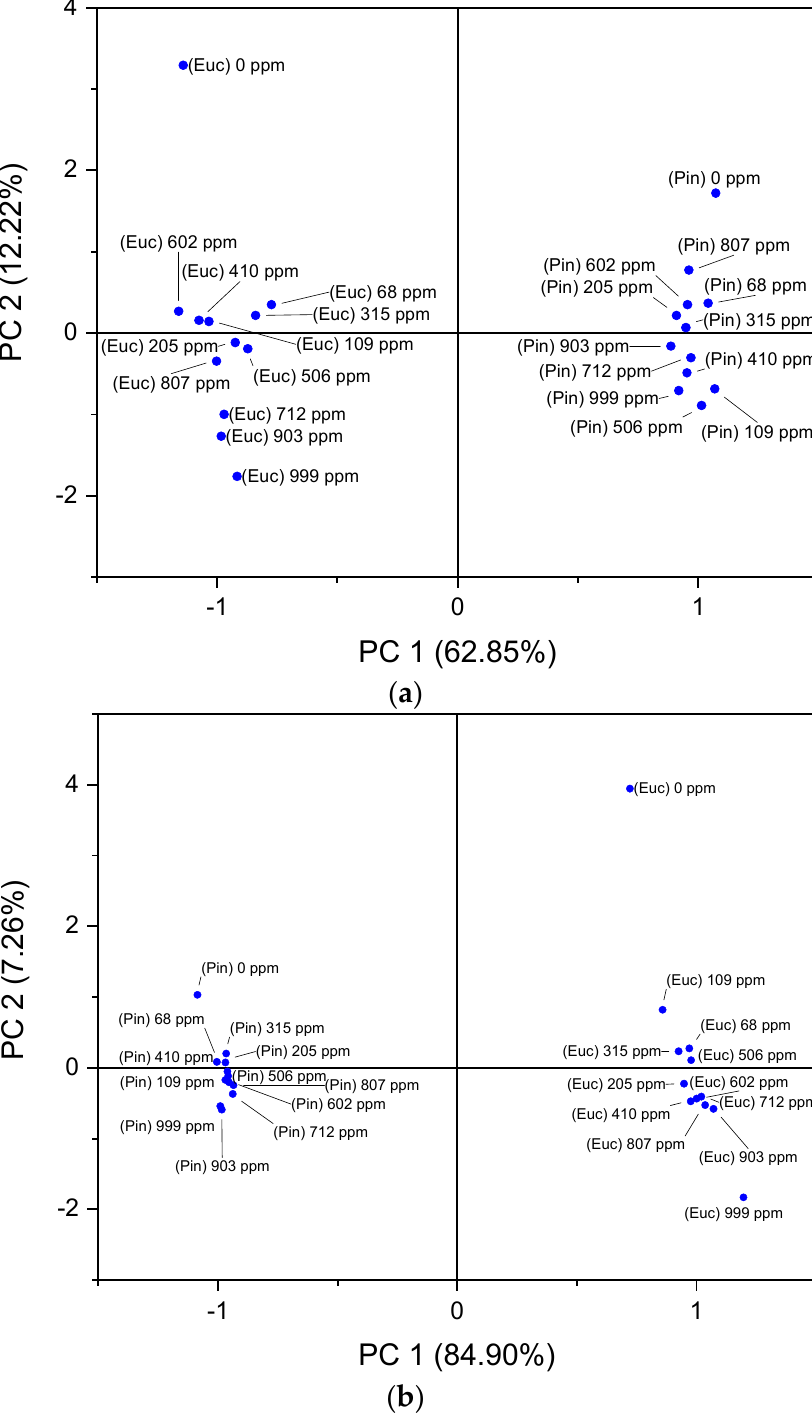
Figure 5. ( a ) PCA score plot for the electronic nose concept, using the array of PAH/GO, PEI/PSS, PEI/GO, PAH/MWCNT, PAH/MWCNT-COOH, TiO 2 and ZnO sensors for the detection of eucalyptol and α -pinene in the concentration range of 68 to 999 ppm v . ( b ) PCA score plot for the electronic nose concept, using the array of ZnO (100% O 2 )- and (PAH/GO) 5 -film-based sensors for the detection of eucalyptol and α -pinene, respectively, in the concentration range of 68 to 999 ppm v . A concentration value of 0 ppm v of both VOCs were used as the blank samples.